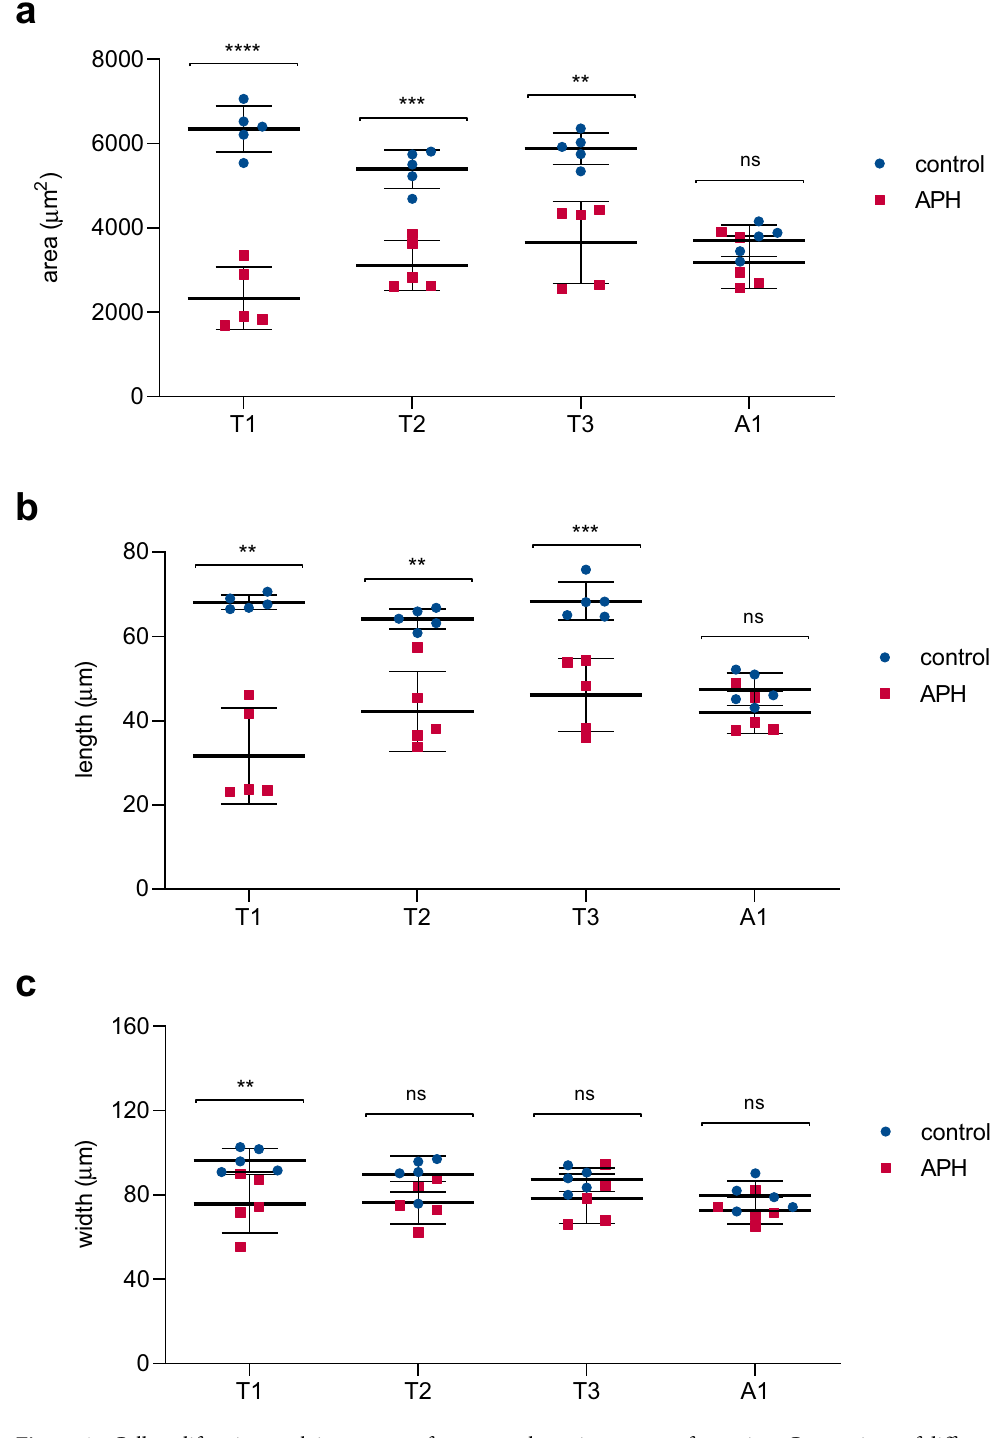
Figure 4. Cell proliferation peak is necessary for proper thoracic segments formation. Comparison of different parameters, area ( a ), length ( b ) and width ( c ), from the three thoracic (T1, T2 and T3) and the first abdominal (A1) segments between APH treated germbands (red squares) and controls (blue dots). Dissected germbands were exposed to the APH treatment or DMSO (controls) during 1-h followed by washout, another 4 h